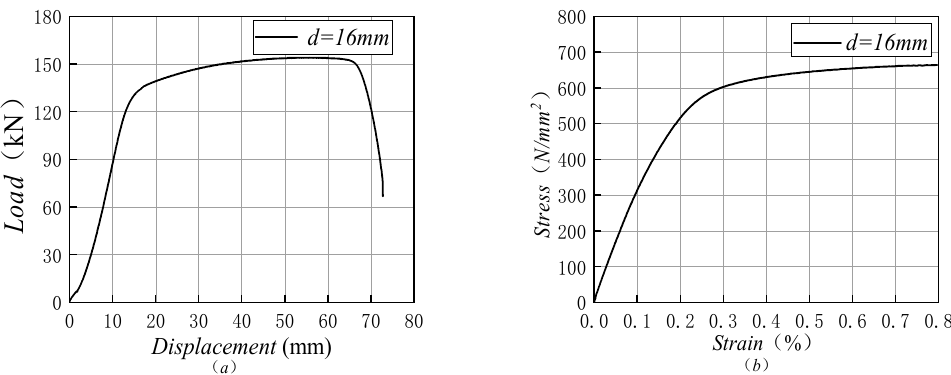
Figure 2. Curve diagram of a duplex stainless steel bar with a diameter of 16 mm. ( a ) is the load-displacement curve; ( b ) is the stress–strain curve.